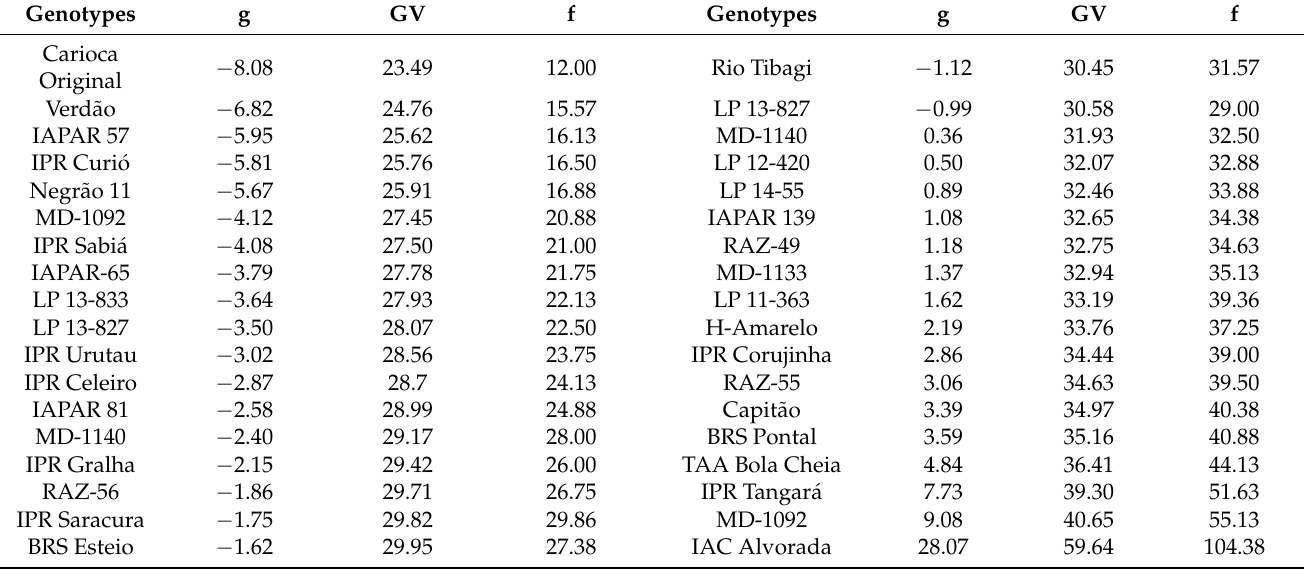
Table 3. Genetic effects (g), genotypic values (GV) and phenotypic mean (f) for common bean genotypes assessed for the number of Polyphagotarsonemus latus on the whole plant.